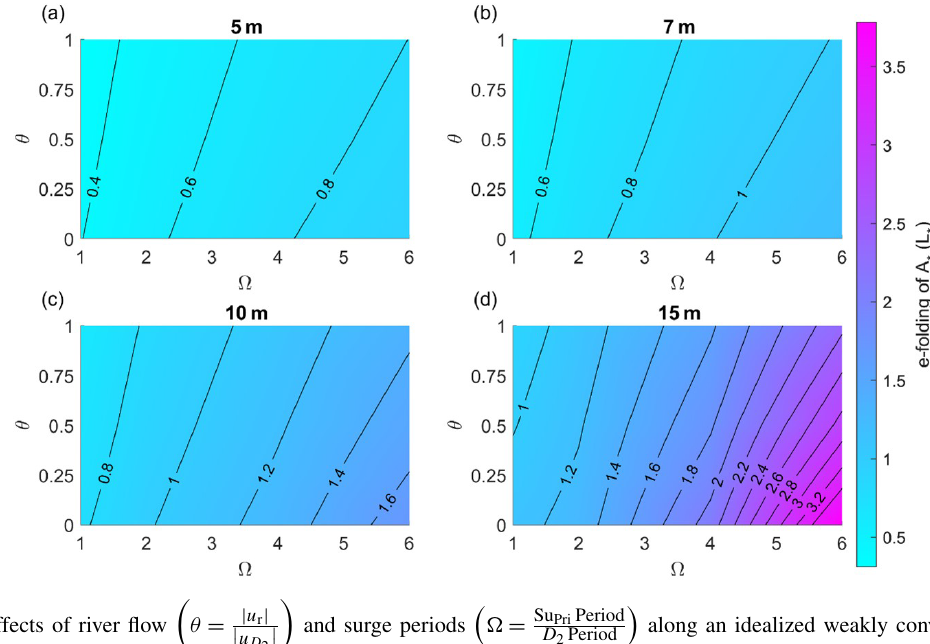
Figure 8. The effects of river flow channel depth of (a) 5, (b) 7, (c) 10, and (d) 15m. The color scaling represents the e -folding length scale of the primary surge-normalized amplitude ( A ∗